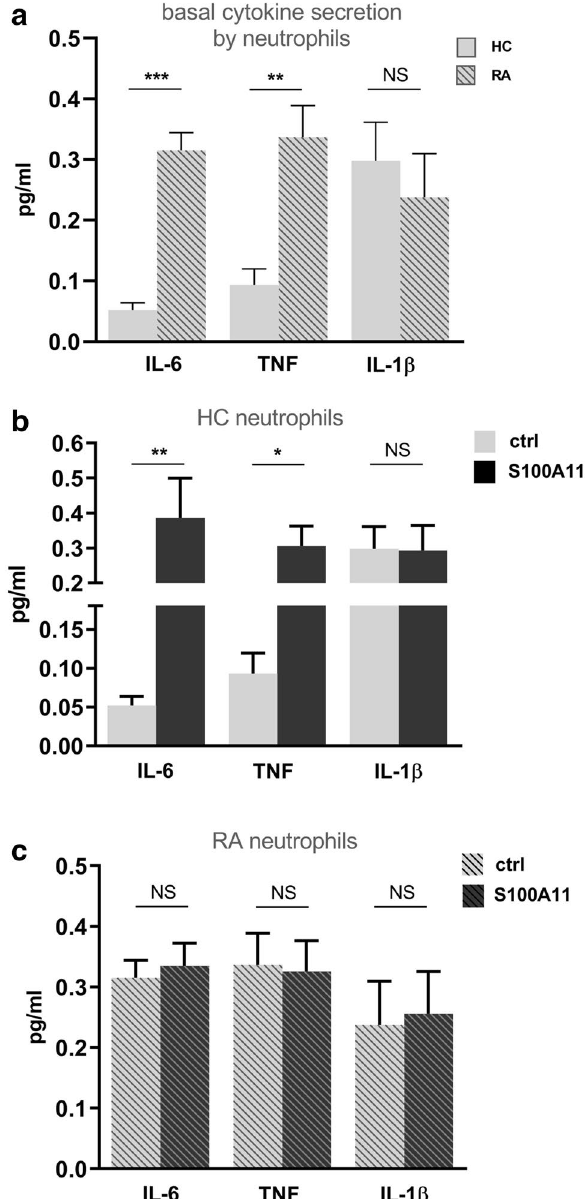
Figure 5. Neutrophils from RA patients showed increased basal secretion of IL-6 and TNF in contrast to neutrophils from healthy controls (HC) ( a ). S100A11-treated HC neutrophils (n = 8–10) exhibited significantly increased secretion of the pro-inflammatory cytokines IL-6 and TNF, but not IL-1β, compared to unstimulated neutrophils ( b ). In contrast, treatment with S100A11 did not affect the release of cytokines by neutrophils from RA patients (n = 6–7) ( c ). Neutrophils were stimulated for 4 h time intervals. HC healthy control, ctrl unstimulated control, NS non-significant. The data are represented as the mean ± SEM. *p < 0.05, **p < 0.01, ***p <